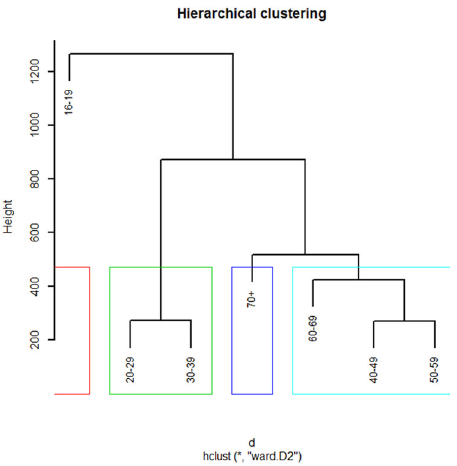
Fig. 6 Similarity of color lexicons. Dendrogram representing age group